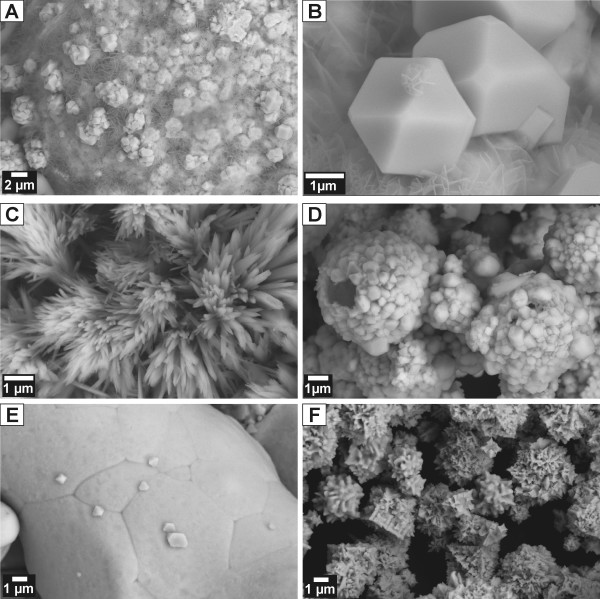
SEM microphotographs of reacted metals and alloys. A) Fe0 reacted in N2(aq) solution depicting coexisting magnetite and Fe-(oxy)hydroxides; B) Detail of magnetite single crystals formed on Fe0; C) clusters of needle-like Fe-(oxy)hydroxide crystals formed on Fe0; D) pseudomorphoses of magnetite after Fe0 in the H2/N2 solution; E) magnetite crystals formed on Ni50Fe50 in the KNO3 solution; F) Ni0 skeletal crystal revealing no change after reaction.